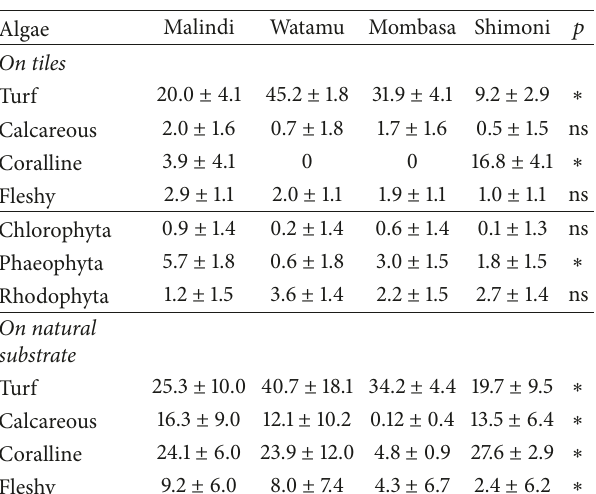
Table 4: Number of coral recruits (family) per tile in Kenyan protected reef lagoons (MLD: Malindi; WTM: Watamu; MSA: Mombasa; SHM: Shimoni).